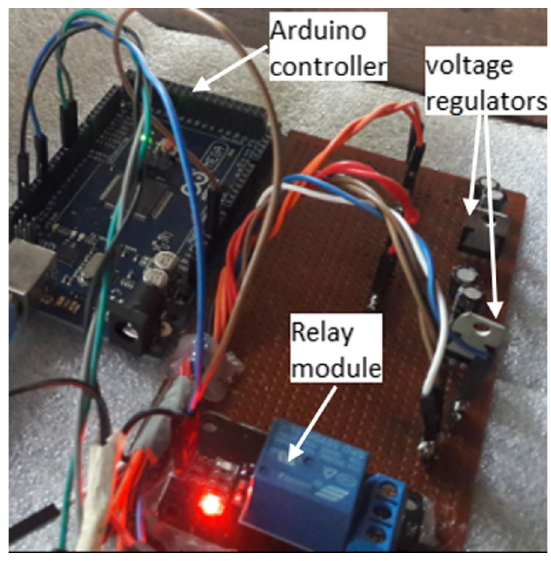
Fig. 4 Electronics of the prototype showing connections between microcontroller, relay module and voltage